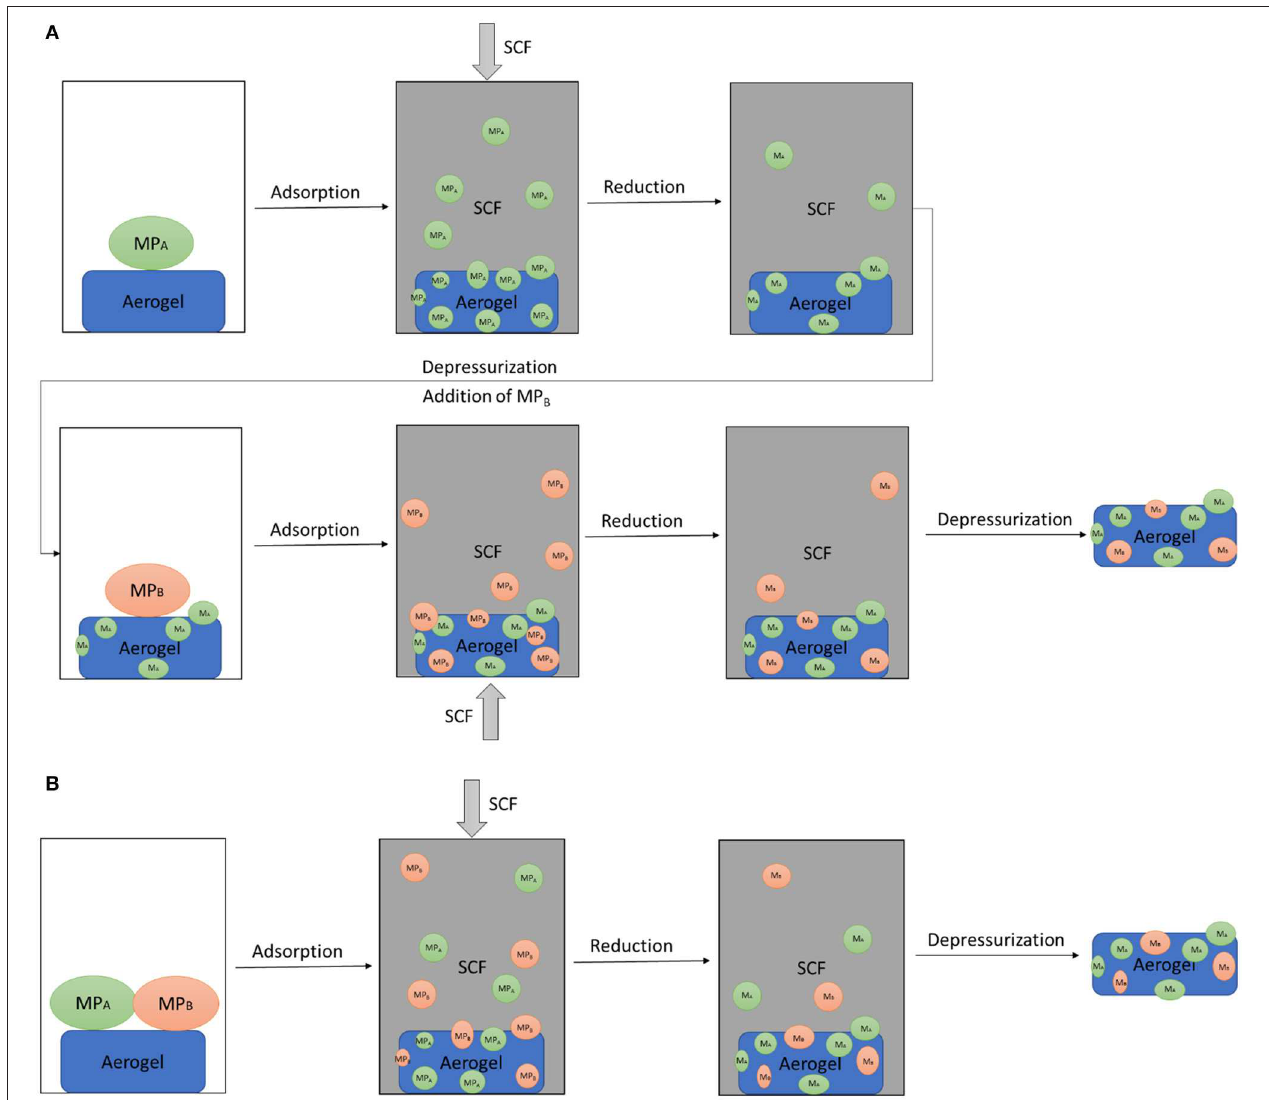
FIGURE 4 | Sequential (A) and simultaneous (B) SCD with in-situ reduction. M, metal; MP, metal precursor, subscripts A and B denote two